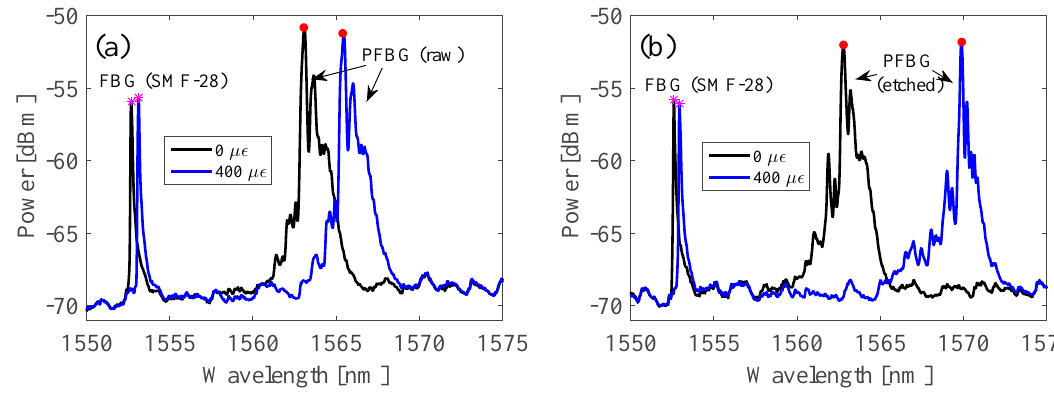
Figure 2. Reflection spectra obtained, when the fibers were unstrained and strained with 400 µ ε , for the sensing head with: ( a ) raw and ( b ) etched POF, considering 2.7 cm mPOF and 1.00 m gauge lengths.